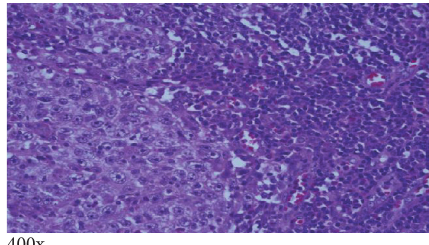
Figure 10: Left chest wall lymph node measuring 3.0 × 2.5 × 1.7 cm poorly differentiated, higher grade squamous cell carcinoma. Extranodal invasion is suspected but not